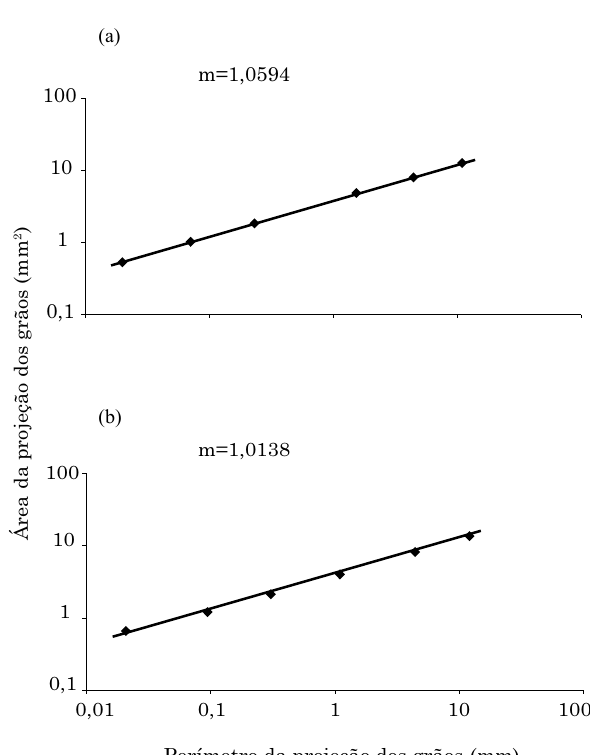
Figura 6. Relação entre a área e o perímetro de projeção dos grãos (escala logarítmica) cujo coeficiente angular (m) foi empregado para cálculo da dimensão fractal de rugosidade (DR). (a) Areia do cordão litorâneo (AJ), e (b) Areia de rio (AR) da região de Vitória,